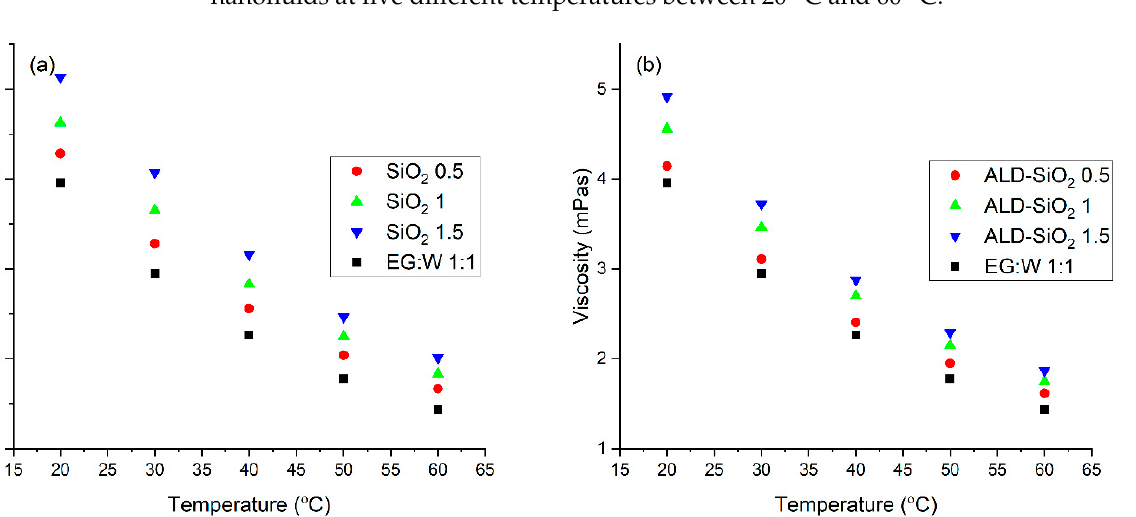
Table 6. Average zeta potential values of the different nanofluids.